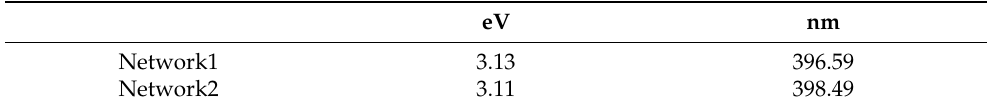
Table 5. Absorption values (eV and nm) calculated for psamFP488 arranged according to Network1 and Network2.